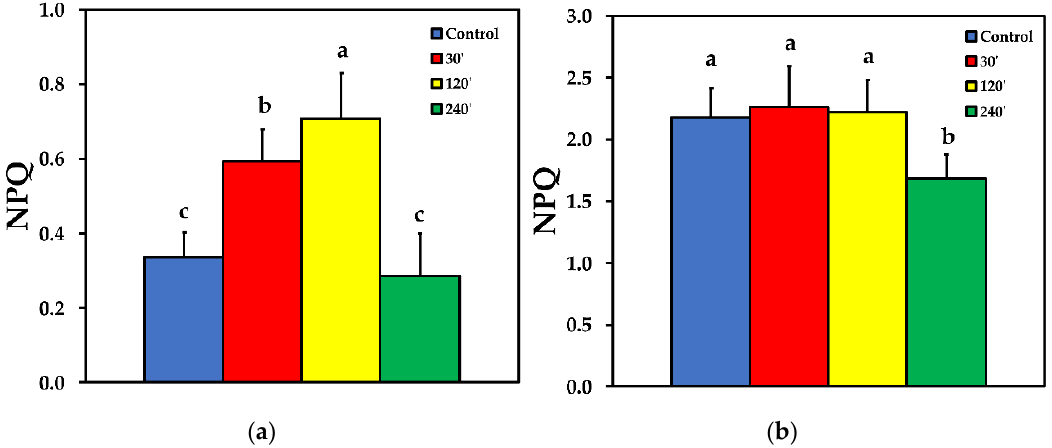
Figure 5. The non-photochemical quenching (NPQ), reflecting heat dissipation, before (control) and after 30, 120 and 240 min of B. cinerea aquatic spore suspensions application on tomato leaflets, measured at 230 μ mol photons m − 2 s –1 ( a ), and at 900 μ mol photons m − 2 s –1 ( b ). Error bars are standard deviations (n = 6). Columns with different letters are statistically different ( p < 0.05).